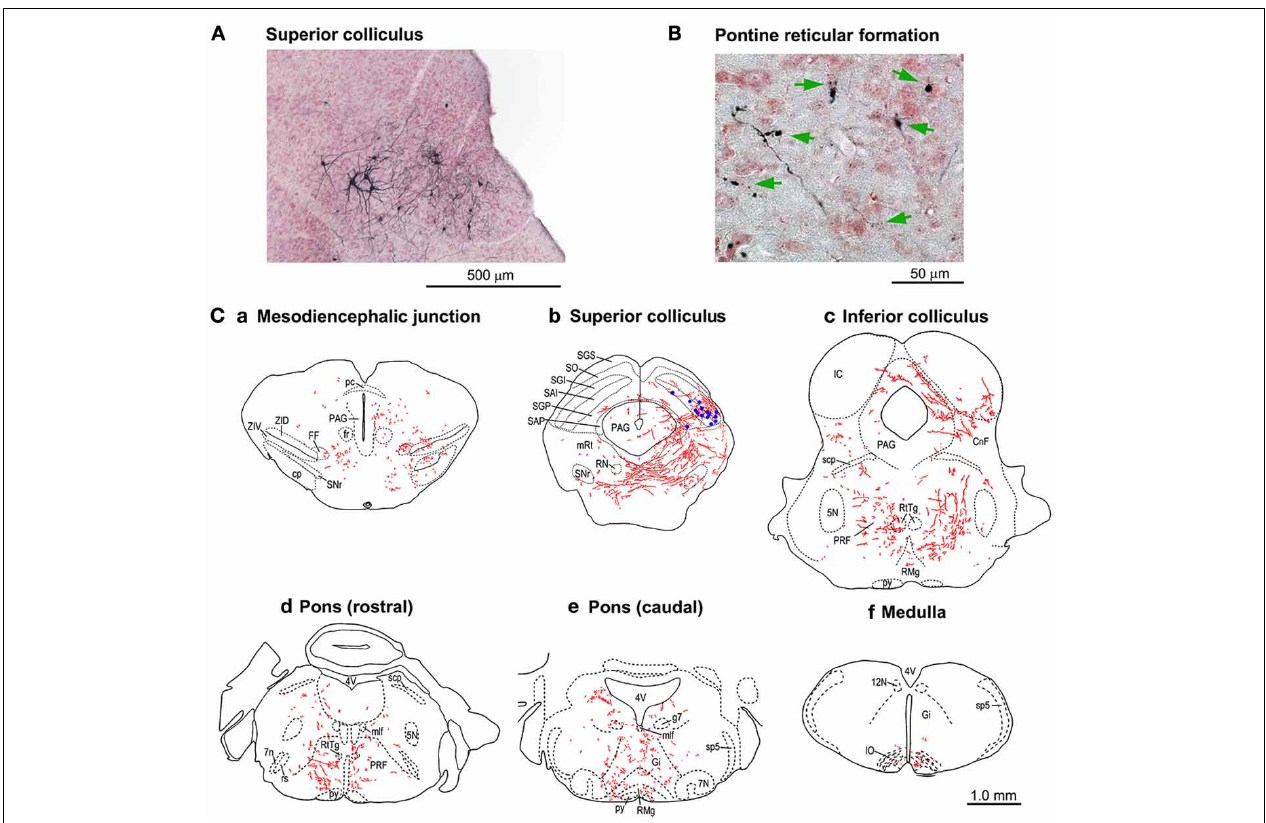
FIGURE 6 | Tracings of the axonal trajectories of the GFP-positive cTRNs in the superior colliculus (SC) in the mice with Dox treatment for 21 days. (A) GFP-positive cTRNs in the right SC. (B) Axon terminals (arrows) in the left pontine reticular formation. (C) Tracings of the axons and their terminals in the brainstem: a. Pretectum; b. Midbrain (SC level); c. Midbrain (inferior colliculus level); d. Pons (rostral part); e. Pons (caudal part); f. Medulla. GFP-positive cell bodies are indicated as blue dots in Cb. Abbreviations: 5N, trigeminal nucleus; 7N, facial nucleus; 7n, facial nerve; 12N, hypoglossal nucleus; CnF, cuneiform nucleus; cp, cerebral peduncle; FF, fields of Forel; fr, fasciculus retroflexus; g7, genu of the facial nerve; Gi,